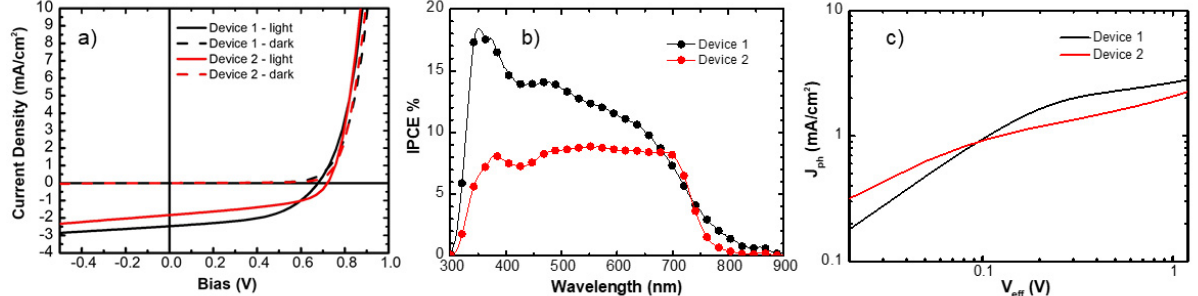
Figure 7. ( a ) J-V behavior, ( b ) EQE spectra and ( c ) J ph -V eff plot of PC 71 BM:PTB7- b -P4VP (1.1:1) Figure 7. ( a ) J ‐ V behavior, ( b ) EQE spectra and ( c ) J ph ‐ V eff plot of PC 71 BM:PTB7 ‐ b ‐ P4VP (1.1:1) blend WPNPs (device 1) and of the device from PC 71 BM:PTB7- b -P4VP (1.5:1) blend in chlorobenzene blend WPNPs (device 1) and of the device from PC 71 BM:PTB7 ‐ b ‐ P4VP (1.5:1) blend in (device 2). chlorobenzene (device 2). Table 3. Photovoltaic parameters of the devices based on PC 71 BM:PTB7- b -P4VP (1.1:1) blend